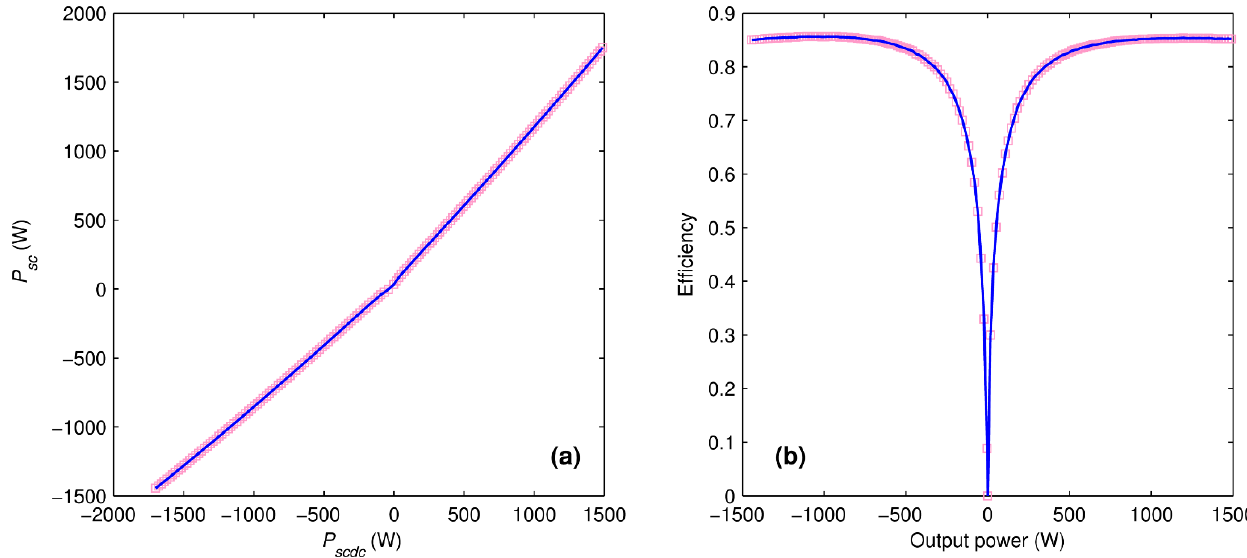
Figure 6. Modeling of the supercapacitor bidirectional DC/DC converter. ( a ) Input-output power relation; ( b )